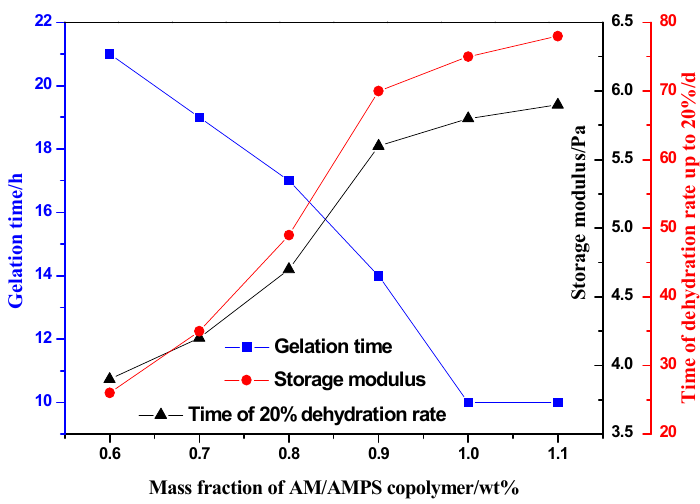
Figure 1. Effect of AM/AMPS copolymer mass fraction on the properties of gel.